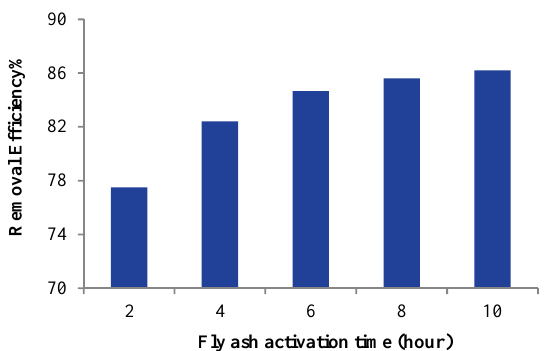
Figure 3. Effect of activation time on cyanide removal [cyanide: 30 mg/l, unadjusted